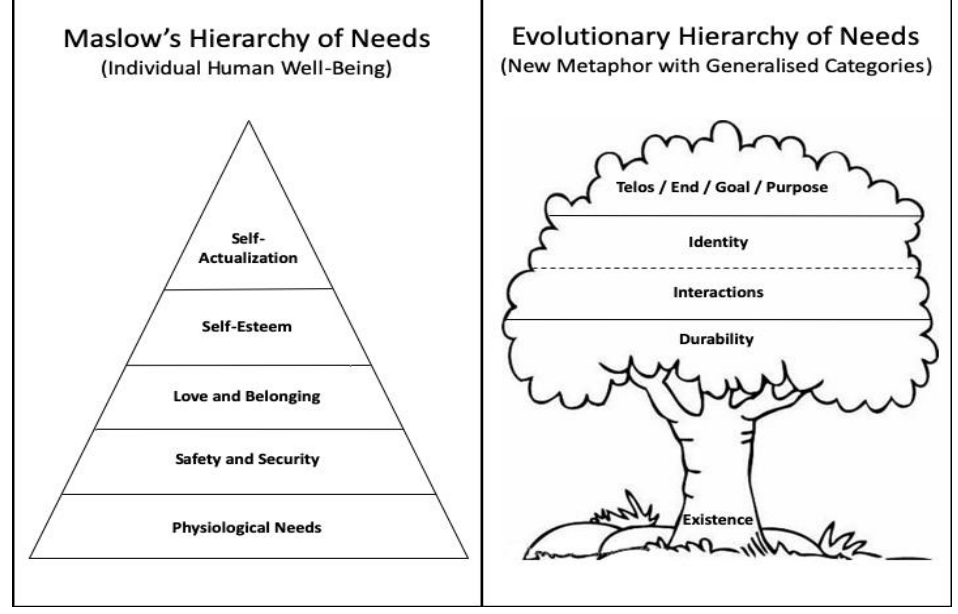
Figure 2: The Shift from Maslow’s View to an Evolutionary View (Source: Gibney